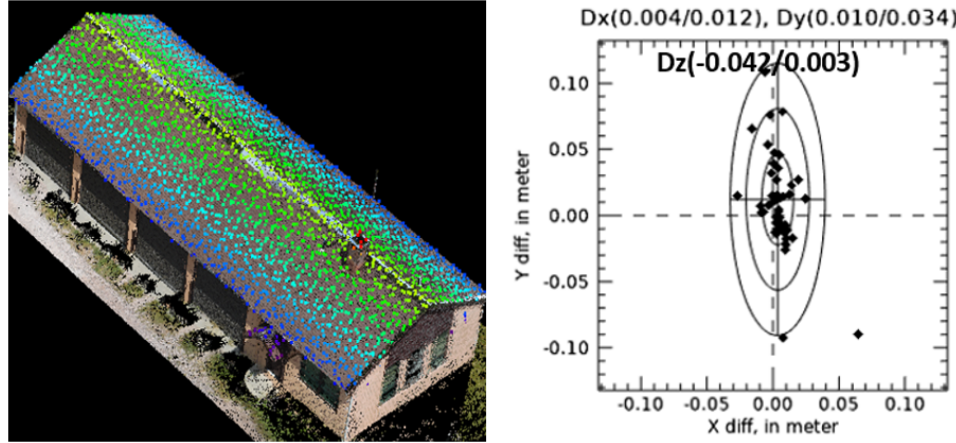
Figure 6. Two-sided roof point cloud ( left ) and the difference optimization result ( right ).